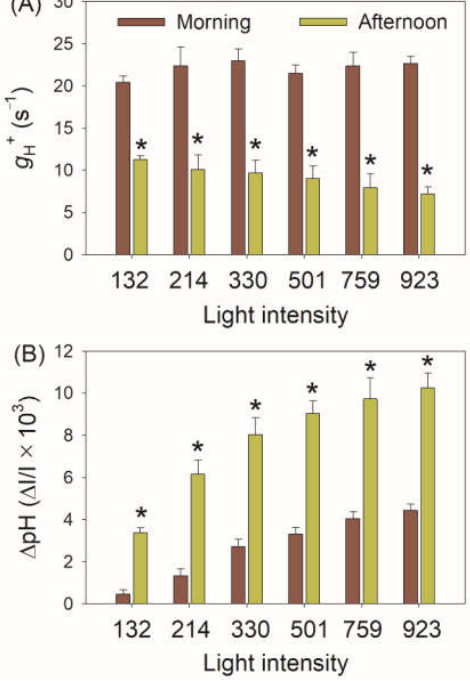
Figure 4. Light intensity dependence of g H+ ( A ) and ∆ pH ( B ) for leaves of Vanilla planifolia measured in the morning and in the afternoon. g H+ , the conductivity of the chloroplast ATP synthase to protons; ∆ pH, proton gradient across the thylakoid membranes. Data are means ± SE ( n = 5). Asterisk indicates a significant difference between morning and afternoon.